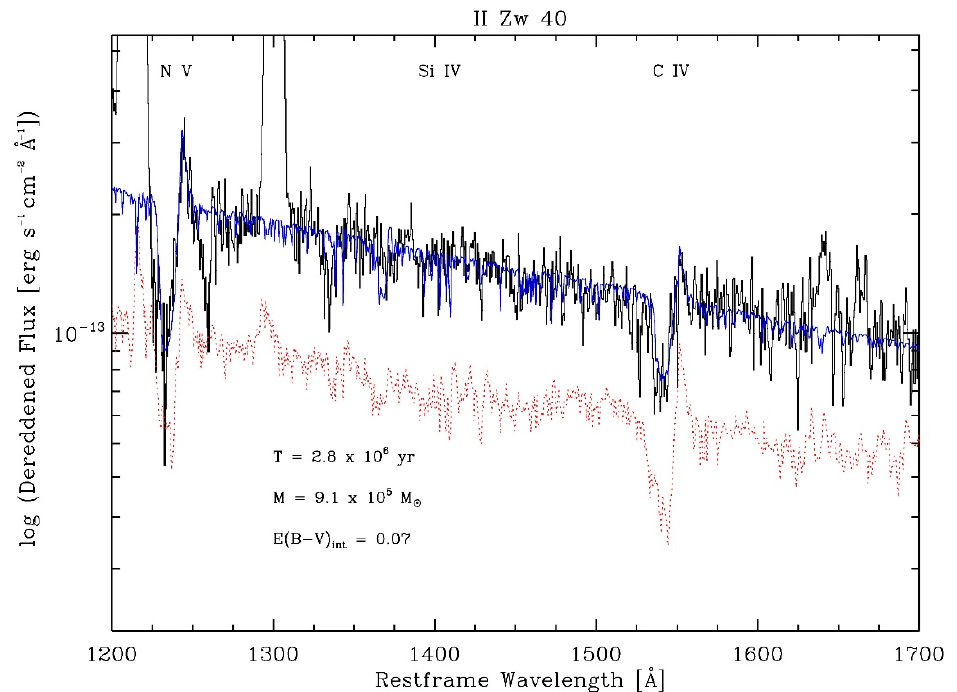
Figure 18. Comparison of the observed spectrum of SSC-N (black) and the best-fit simulation (blue). The data are in restframe wavelengths and have been corrected for the Milky Way and internal reddening. The model assumes a star cluster of mass 9.1 × 10 5 M (cid:12) , age 2.8 × 10 6 yr and chemical composition of 1 / 7 th solar. For comparison, the best-fit model with solar chemical composition is shown as well (red, dashed). From